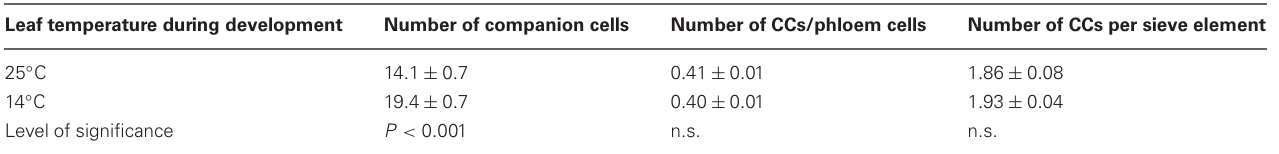
Table 2 | Companion cell (CC) number, number of companion cells relative to all phloem cells, and number of companion cells per sieve element (SE) in the minor loading (third and fourth order) veins of leaves of the Swedish ecotype of A. thaliana that developed under